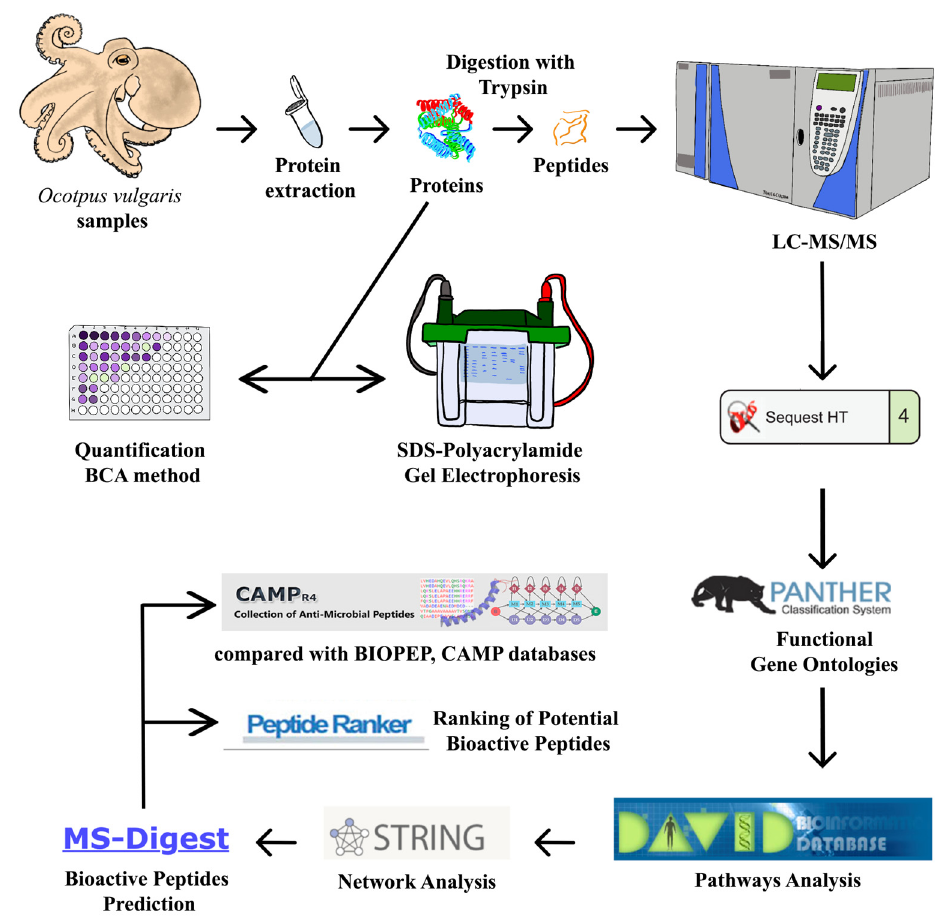
Figure 6. Workflow used to perform the extraction, quantification, and digestion of proteins. On the other hand, the steps followed the LC-MS/MS analysis for the bioinformatics study of the obtained proteins are shown.